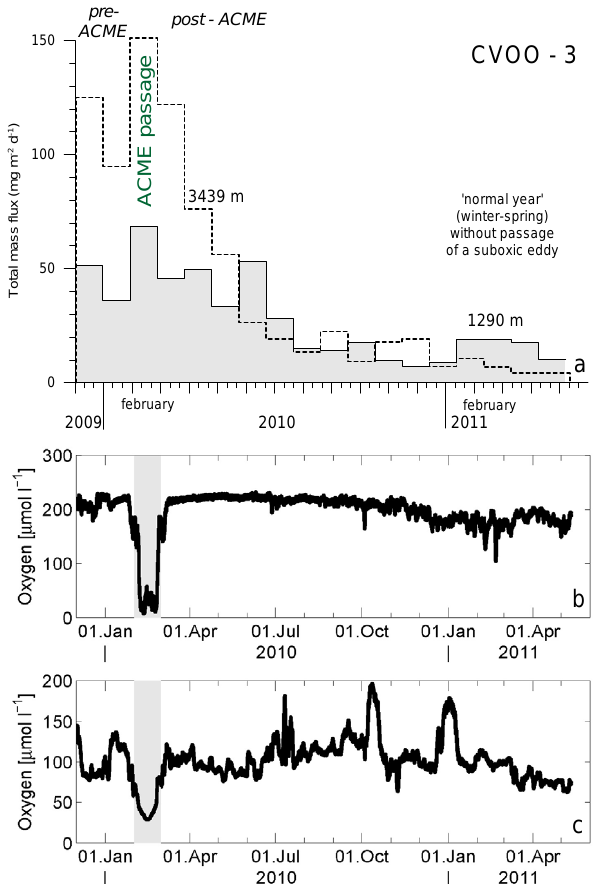
Figure 3. Total mass fluxes collected with the upper and lower sed- iment traps at CVOO-3 (a) . Oxygen time series at approx. 42m (b) and 170m (c) water depths (Karstensen et al., 2015); grey bar in- dicates the ACME passage in February 2010. Upper and lower trap fluxes are highly correlated ( r 2 = 0.7; N = 17); however, lower trap mass fluxes are roughly twice as high during winter–spring 2010 when the ACME passed the site. The common pattern can be seen in winter 2011 during the eddy-free year.